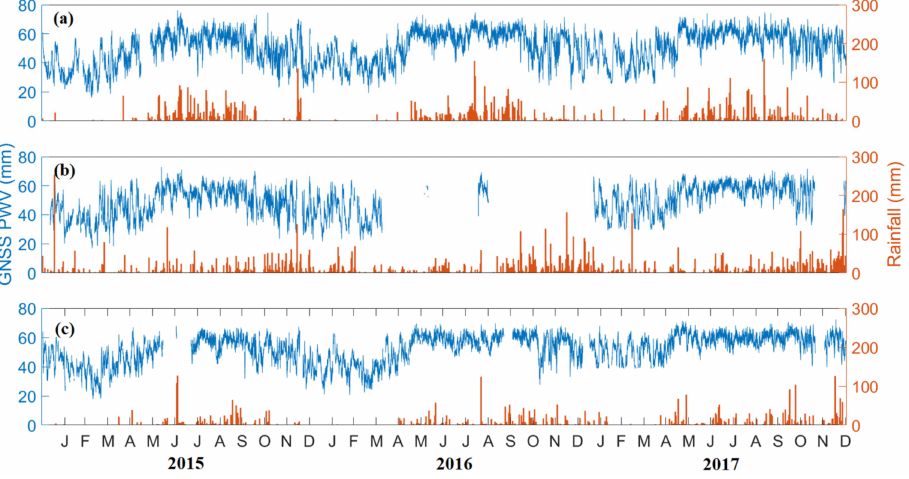
Figure 5. Daily variation of GNSS PWV (blue) in ( a ) PIMO, ( b ) Legaspi, and ( c ) Puerto Princesa, along with the daily rainfall (orange) from 2015 to